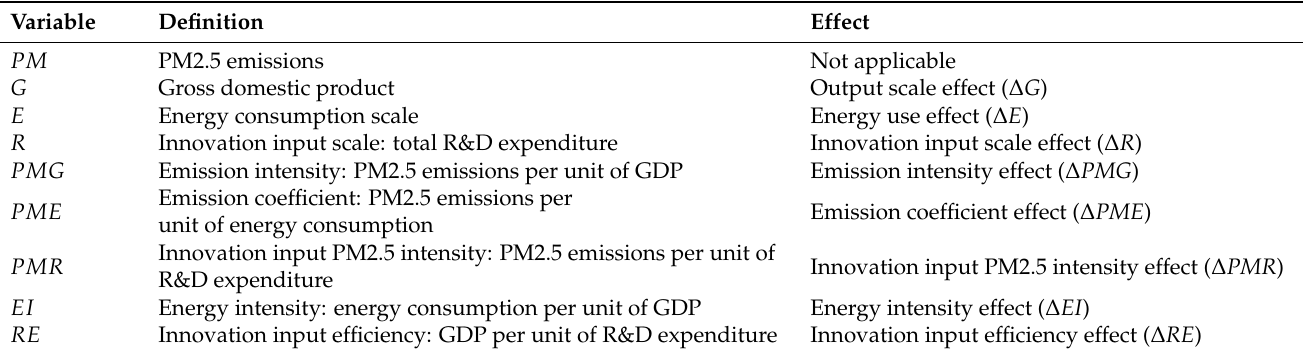
Table 1. Definition of variables in GDIM